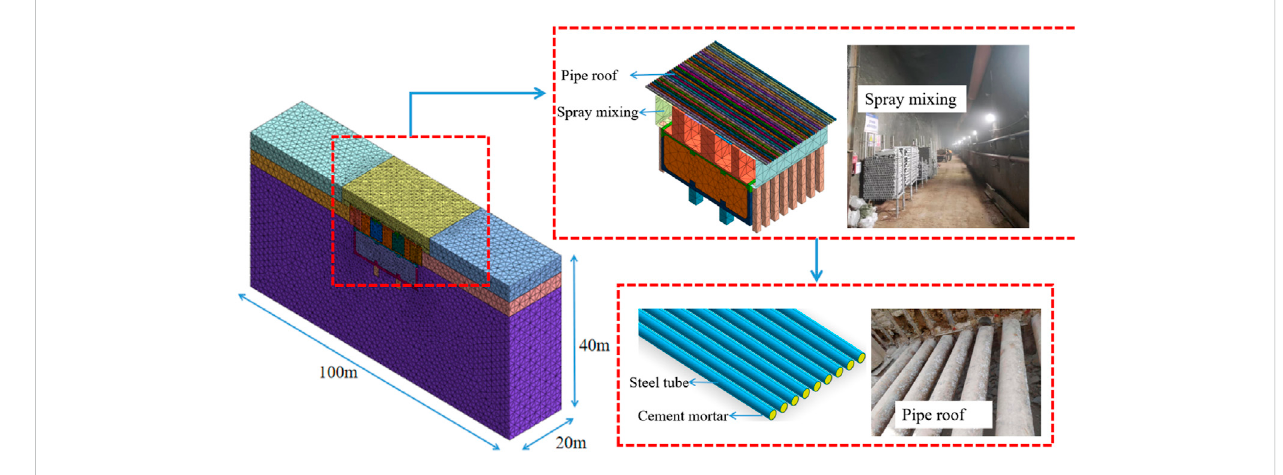
FIGURE 8 Three-dimensional fi nite element model.